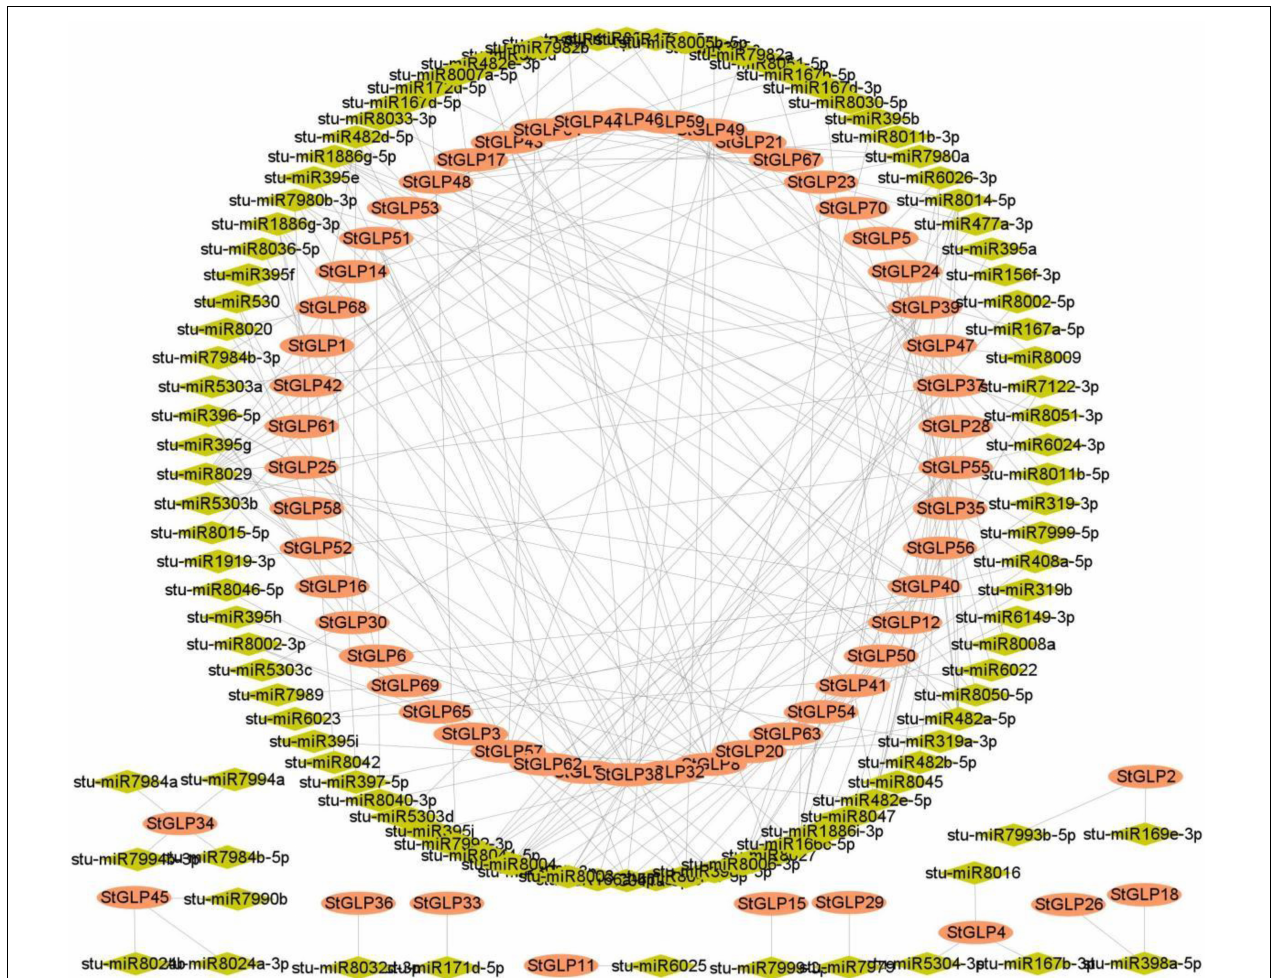
FIGURE 6 | miRNAs targeting StGLP genes. Network figure of anticipated miRNAs targeting the StGLP genes. Green color represents miRNAs, while orange color corresponds to the target StGLP